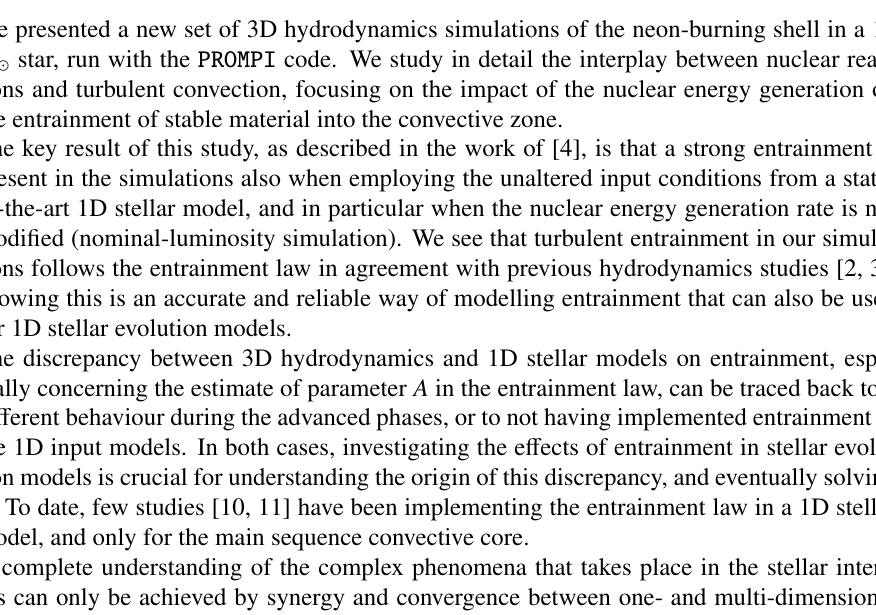
Figure 3. Entrainment rate vs. bulk Richardson number and linear regressions: Ne-shell from this study (blue, solid), C-shell from [3] (green, dashed), O-shell from [2] (orange, dot-dashed). Triangles are for the lower convective boundaries, circles for the upper ones. The boosting factor is inversely proportional to Ri B , equal to 100, 10, 1 for the two triplets of blue circles and triangles. Error bars are standard deviations, computed in this work for the first time. Figure taken from